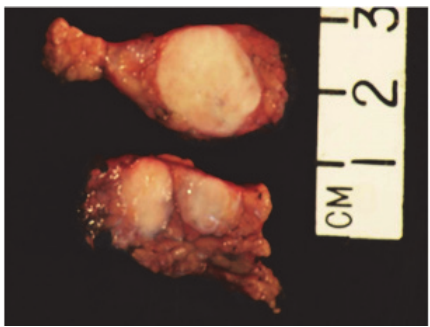
Figure 2: Gross specimen of the resected pancreas with the mass lesion (pancreatic elastofibroma).